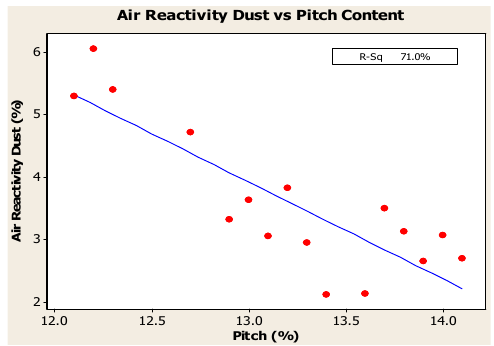
Figure 8. Air reactivity dust (RD) vs. pitch content.